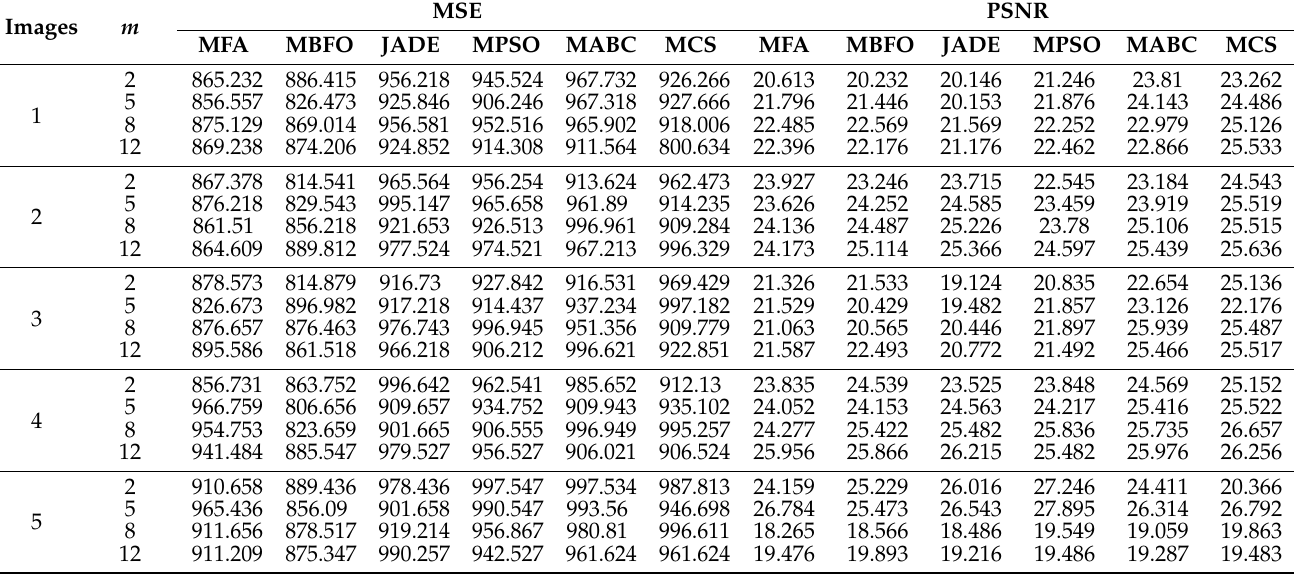
Table A7. MSE and PSNR computed using different optimization algorithms with GLCM method.